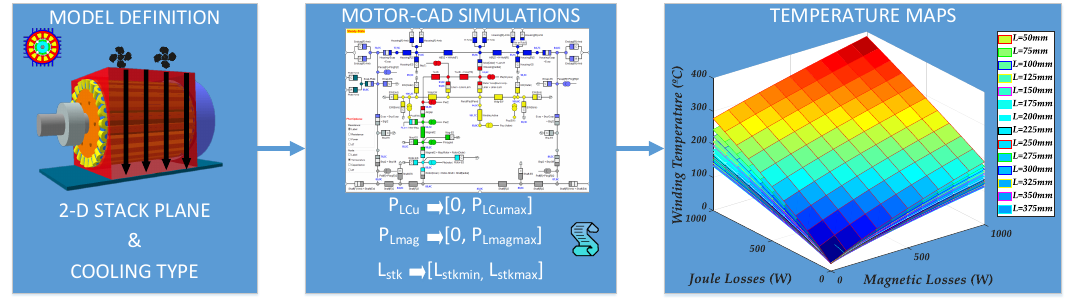
Figure 5. Temperature map